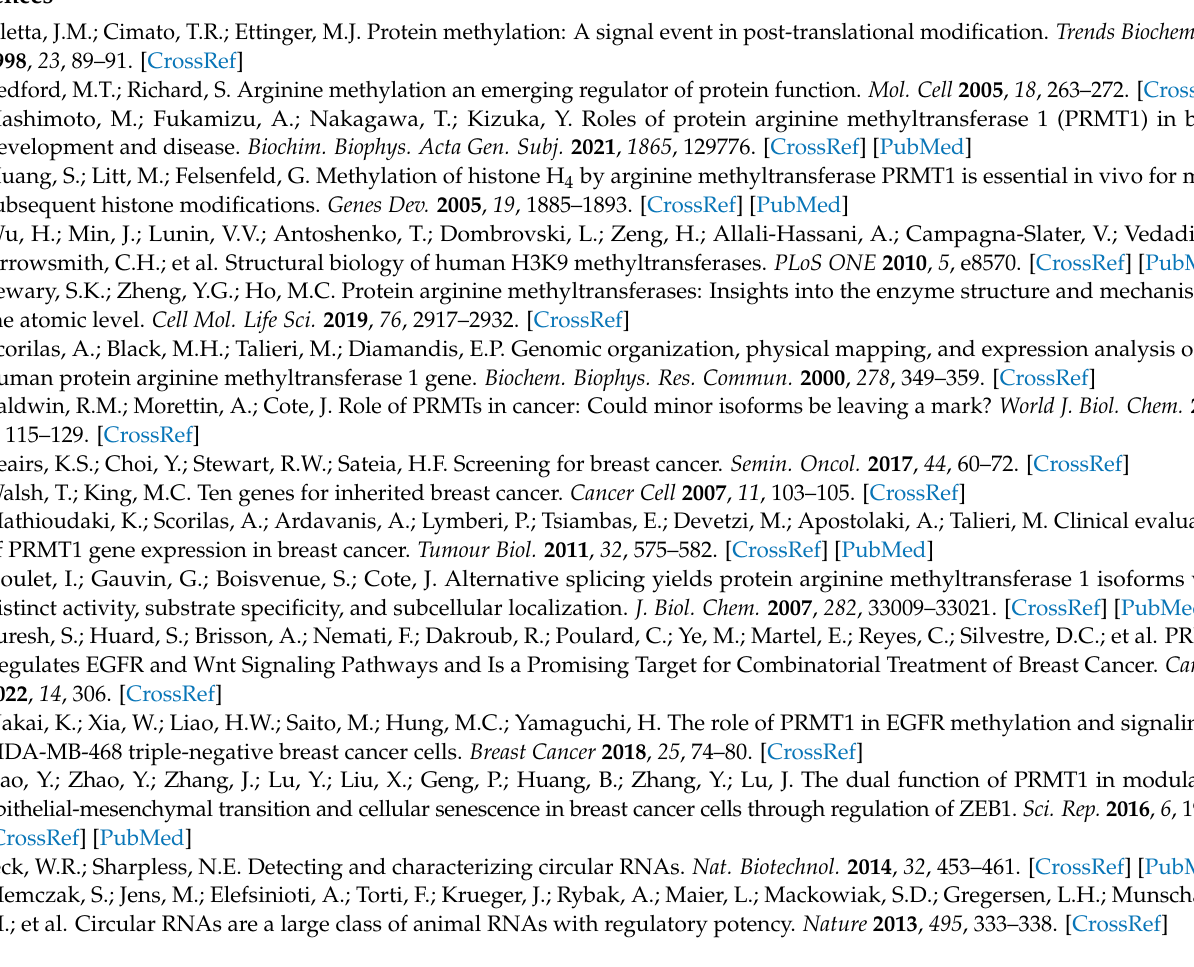
binding motif are outlined in red color; Figure S3: Local secondary structures of the predicted m 6 A sites in the five novel PRMT1 circRNAs that possess an open reading frame. The bases around the predicted m 6 A sites are highlighted in orange. If multiple motifs existed in the same region, only the one with the highest prediction score is illustrated; Table S1: Characteristics of the four breast cancer cell lines that were used in the study; Table S2: Primers used in first- and second-round PCR assays for the selective amplification of PRMT1 circular variants and the main variant of GAPDH ; Table S3: The full list of miRNAs that are predicted to bind to the novel PRMT1 circRNAs, according to the miRDB database; Table S4: The RBPs that are predicted to bind to the novel PRMT1 circRNAs, as resulted from RBPmap; Table S5: The results from the Kyoto Encyclopedia of Genes and Genomes (KEGG) pathway analysis regarding the miRNA-targeted mRNAs, whose expression is predicted to be affected by the nine PRMT1